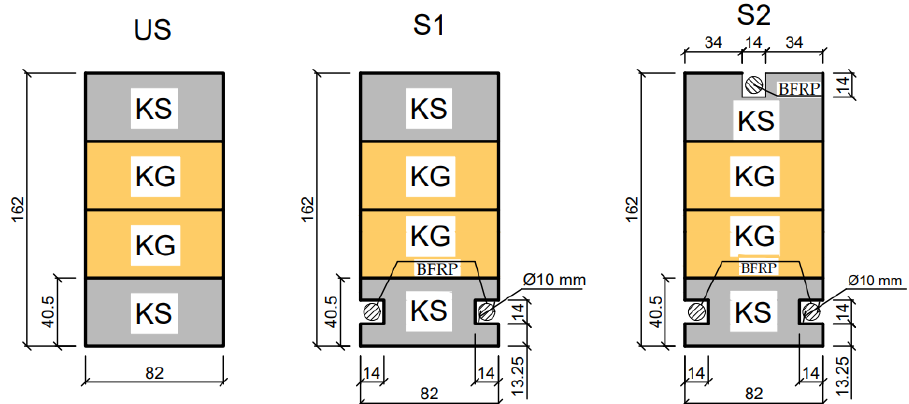
Figure 2. The configuration of the strengthened beams (US—unstrengthened beams; S1—beams strengthened with two pre-stressed BFRP bars in the tension zone; S2—beams strengthened with pre-stressed BFRP bars in the tension and compression zones; KG—class of inferior quality structural timber; and KS—class of medium quality structural timber).